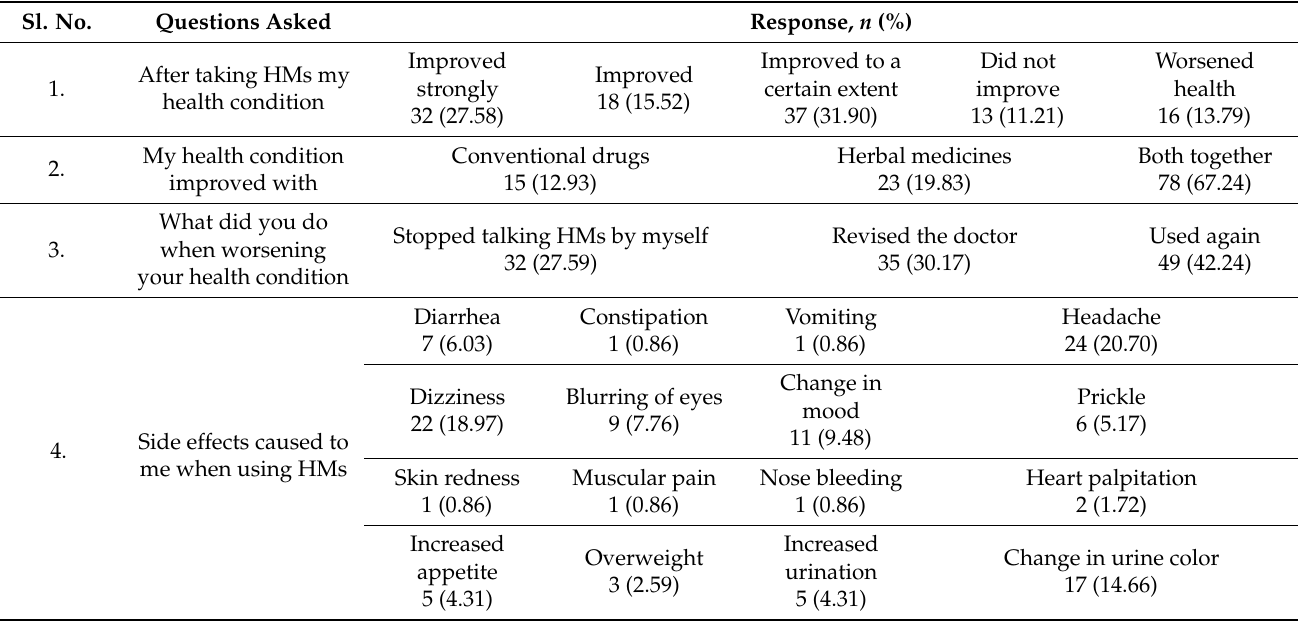
Table 5. Respondents’ beliefs about side effects of HMs ( n = 116 out of